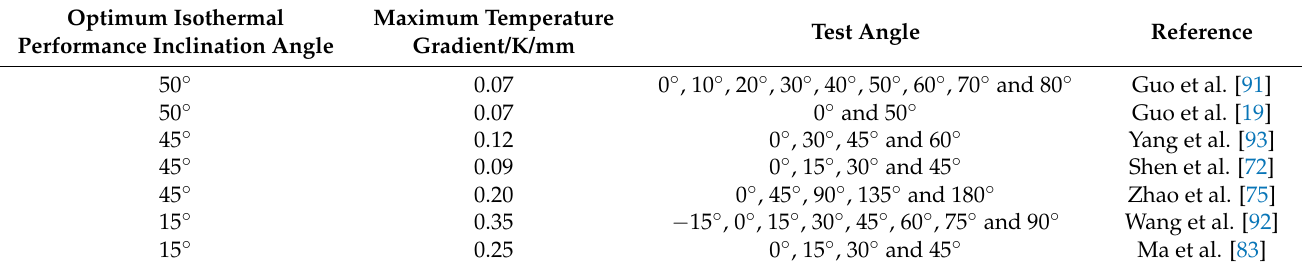
Table 9. Effect of the isothermal performance on inclination angle of heat